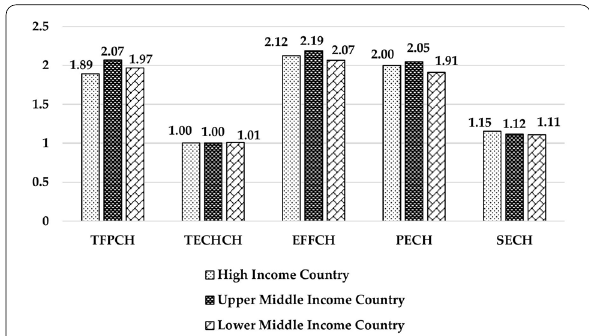
Fig. 11 TFPCH for Conventional Banks in Different Income Groups from Year 2008 to